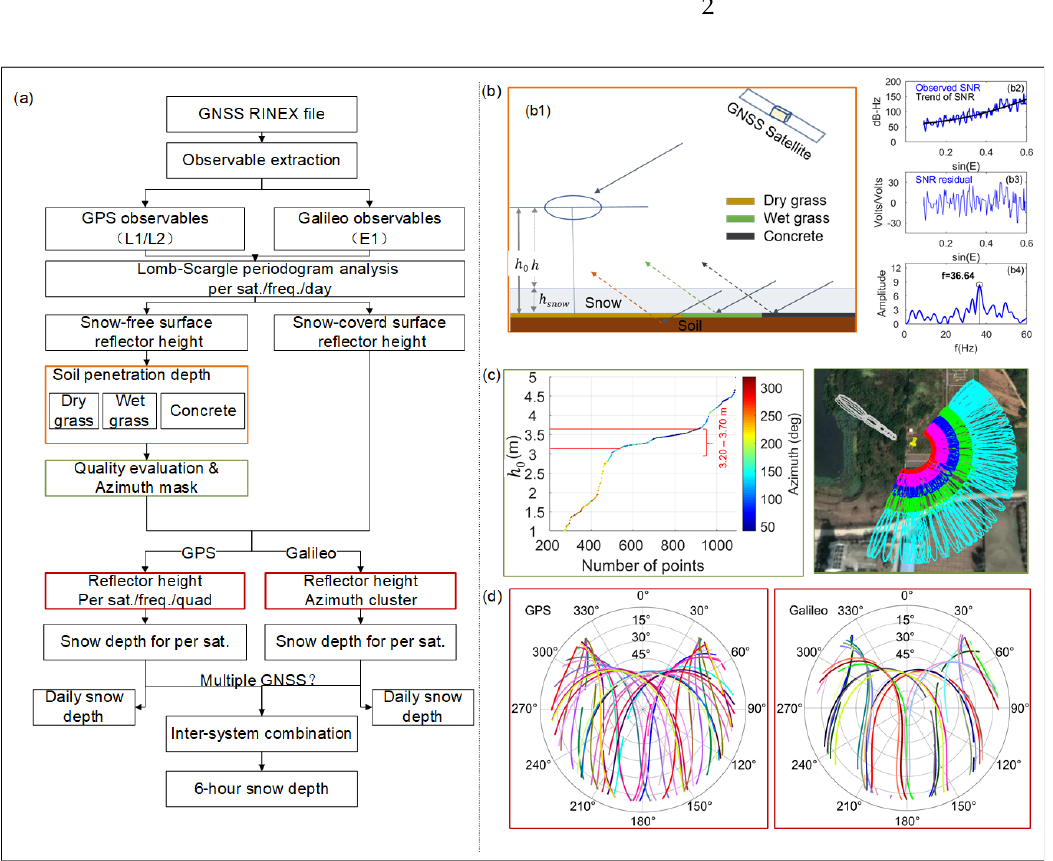
Figure 2. Flowchart of the data processing. ( a ) Flowchart of snow depth estimation. ( b ) Observation geometry and the principle of the SNR model. ( b1 ) Basic geometry. ( b2 ) Observed SNR and the trend of SNR, taking DOY 32 of Site “BFHO” as an example. The trend was estimated by fitting observed SNR by a second-order polynomial. ( b3 ) Interference pattern between direct and reflected GNSS signal. ( b4 ) Lomb-Scargle periodogram with the dominant frequency. ( c ) Quality evaluation and azimuth mask, taking DOY 37 of Site “BFHO” as an example. Left: initial determination of ℎ 0 . Right: the footprints (Fresnel zones) used after the azimuth mask. Different colors indicate the foot- prints for elevation angles of 10°, 15°, 20°, 25°, and 30°, respectively. The gray azimuths are invalid. ( d ) The satellite traj ectory of GPS and Galileo, taking DOY32 of Site “CZCZ” as an example. The cut-off elevation angle in ( d ) is 10°. The flow chart of data processing is shown in Figure 2a. Several specific issues should be considered during the procedure. First, the quality of the reference reflector height should be controlled to make it accurate. Second, the penetration depths of the ground surface substances should be removed while calculating the reference reflector heights for the snow-free surface. Third, the non-repeatable Galileo tracks should be processed sepa- rately to eliminate the terrain effects. Finally, the GPS and Galileo data are combined to derive the 6 h resolution snow depths. The following Sections 2.2.1, 2.2.2, 2.2.3, and 2.2.4 give detailed descriptions of the above issues.